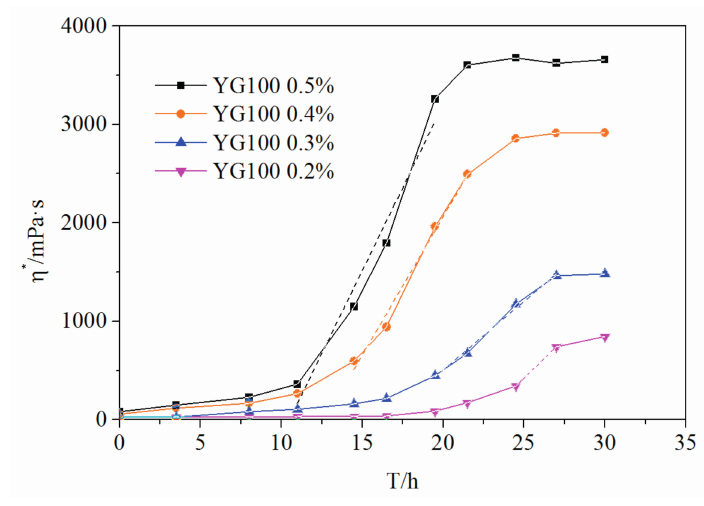
Figure 5. Polymer concentration effect on crosslinking reaction process of the polymer gel.